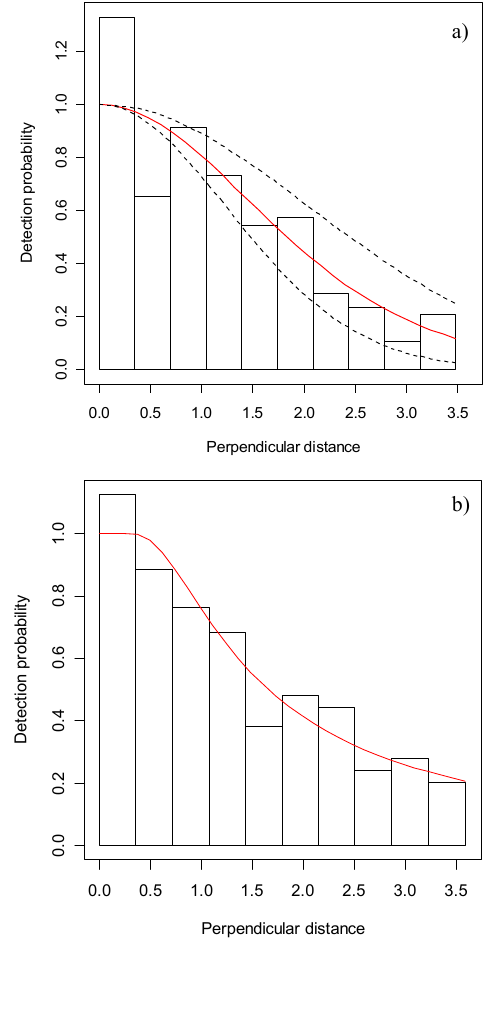
Fig. 5. Overall perpendicular distance (km) distribution and detection function for a) NASS-95 shipboard survey and b) NASS-2001 shipboard survey. The red line is the average fitted detection function. In the case of figure a) this is averaged across cloud cover and vessel. Dashed black lines in a) indicate the detection functions for each